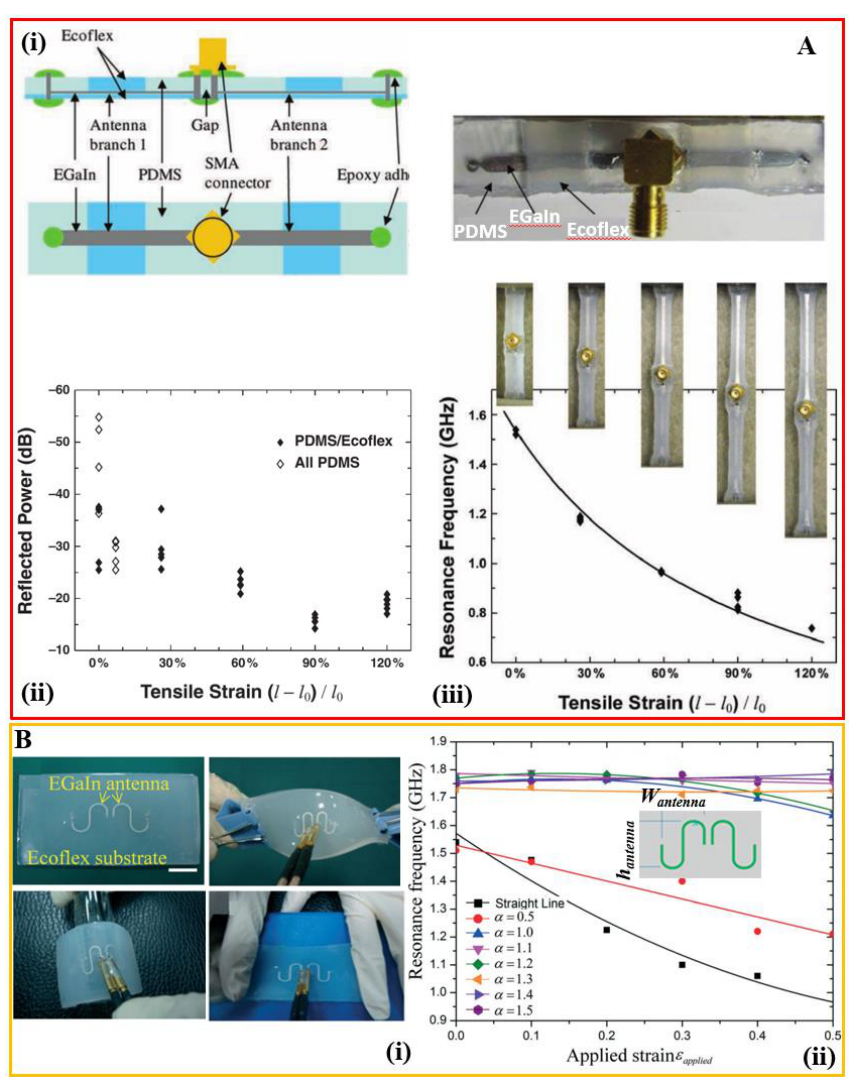
Figure 3. Structural design of the microfluidic antenna filled with the liquid metal ( Ai ) Schematic and optical image of the structural design used to improve the stretchability of the dipole antenna that is based on the liquid metal. ( Aii ) Resonance change as a function of a tensile strain. ( Aiii ) Comparison of the radiation efficiency of the antenna with (i.e., PDMS/Ecoflex) or without (i.e., all PDMS) structural engineering under various levels of tensile strain. Notably, failure of the “all-PDMS” structure occurs for a tensile strain of 20%. Reproduced with permission from [57]; Copyright 2010, John Wiley and Sons. ( Bi ) Optical images of the microfluidic dipole antenna filled with the liquid metal with two serpentine arms in an undeformed state, and being twisted, bent, and stretched. ( Bii ) The resonance frequency change as a function of the tensile strain. Depending on the specific aspect ratio (i.e., the ratio of nominal height h antenna to width W antenna ), the microfluidic antenna can be designed to be strain-dependent or independent. Reproduced with permission from [64]; Copyright 2014, Royal Society of Chemistry.